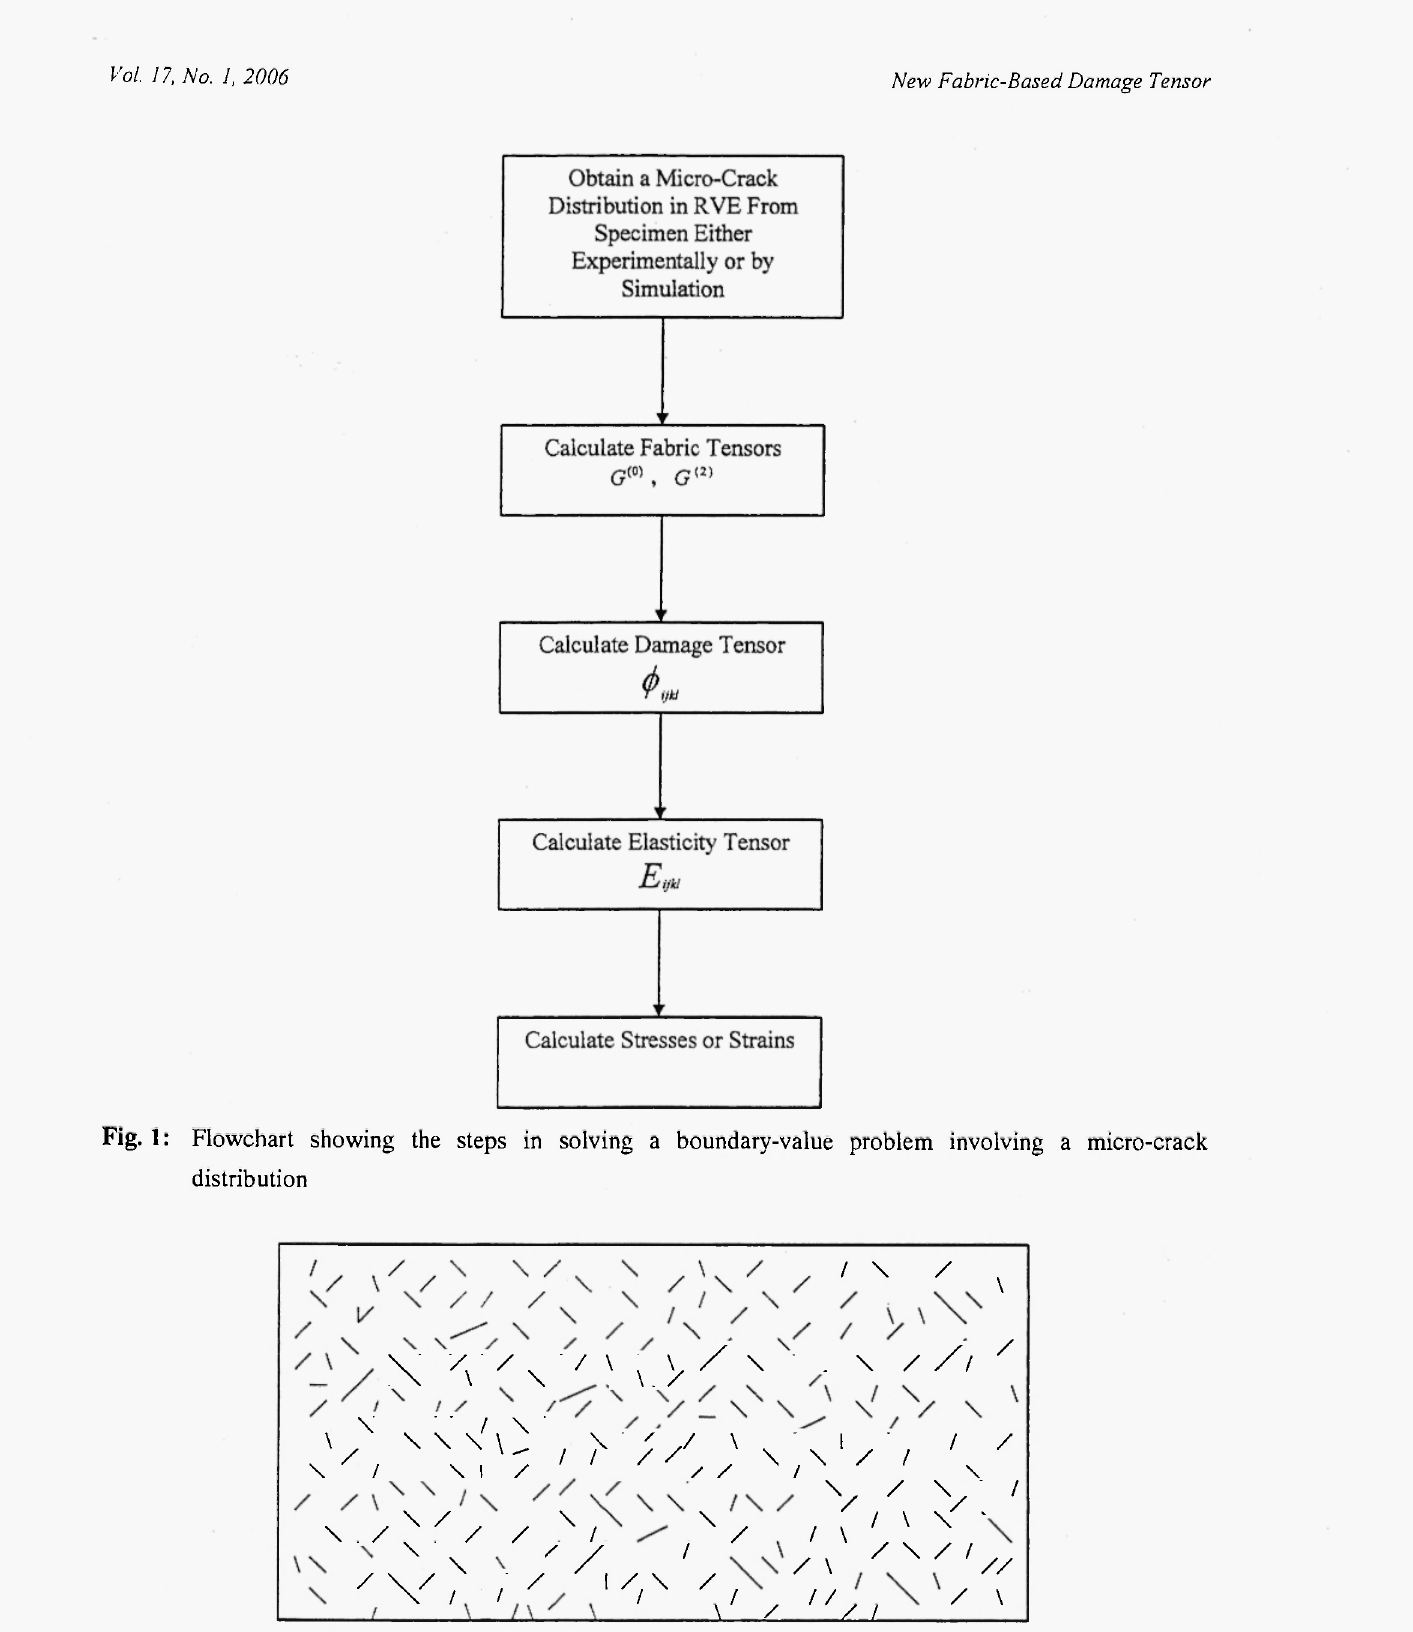
Fig. 2: A cross-section showing a typical random micro-crack distribution